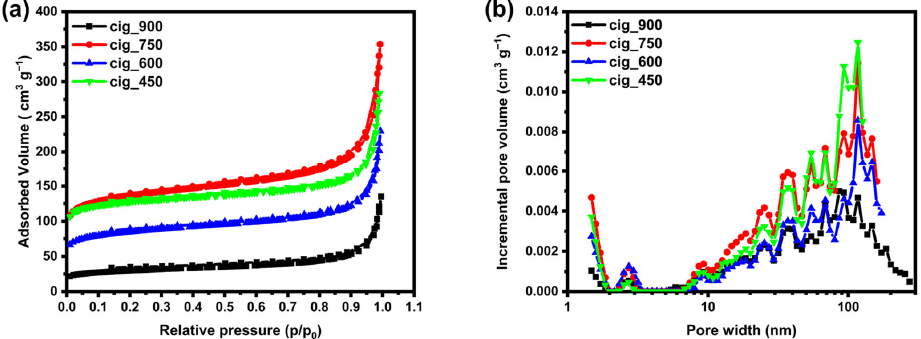
Figure 5. N 2 adsorption–desorption isotherms ( a ) and pore size distribution ( b ) of the four tested electrocatalysts.